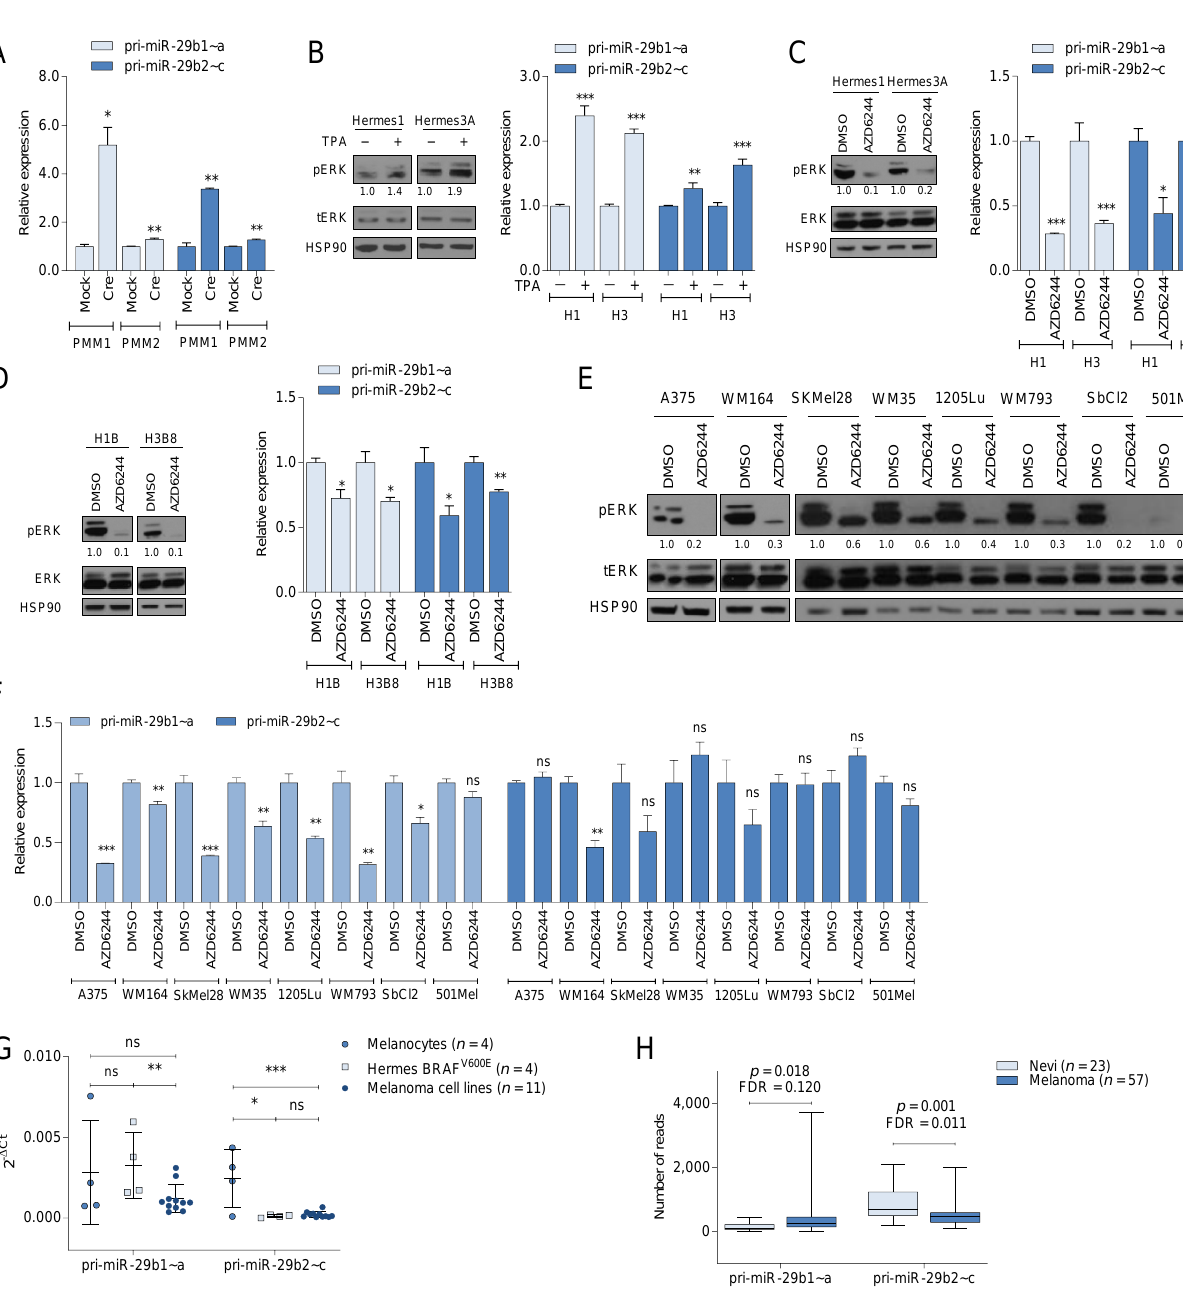
Figure 1. MAPK signaling and p53 regulate miR-29 in human melanocytes and melanoma. ( A ) qRT-PCRs showing the expression of pri-miR-29b1~a and pri-miR-29b2~c in LSL-Braf V600E primary mouse melanocytes (PMM) following Adeno-Cre/Mock infection; ( B ) effect of TPA on pri-miR-29b1~a and pri-miR-29b2~c expression in human melanocytes; ( C ) effect of AZD6244 on pri-miR-29b1~a and pri-miR-29b2~c expression in human melanocytes; ( D ) effect of AZD6244 on pri-miR-29b1~a and pri-miR-29b2~c expression in H1B and H3B8 cells; ( E , F ) effect of AZD6244 on pri-miR-29b1~a and pri-miR-29b2~c expression in human melanoma cells; ( G ) expression of pri-miR-29b1~a and pri-miR-29b2~c in human melanocytes ( n = 4), BRAF V600E melanocytes ( n = 4) and melanoma cell lines ( n = 11); ( H ) expression of pri-miR-29b1~a and pri-miR-29b2~c in nevi ( n = 23) and melanoma ( n = 57) in the GSE112509 dataset. pri-miR-29b1~a and pri-miR-29b2~c qRT-PCRs are shown in the right panels while Western blots are shown in the left panels of ( B – D ). The mean ± SEM of one representative out of two independent experiments performed in triplicates is shown. RNA expression is normalized to β -Actin. All Western blots show the intensity ratio of the protein of interest normalized to HSP90. ns, not significant; FDR, false discovery rate; * p < 0.05; ** p < 0.01; *** p <